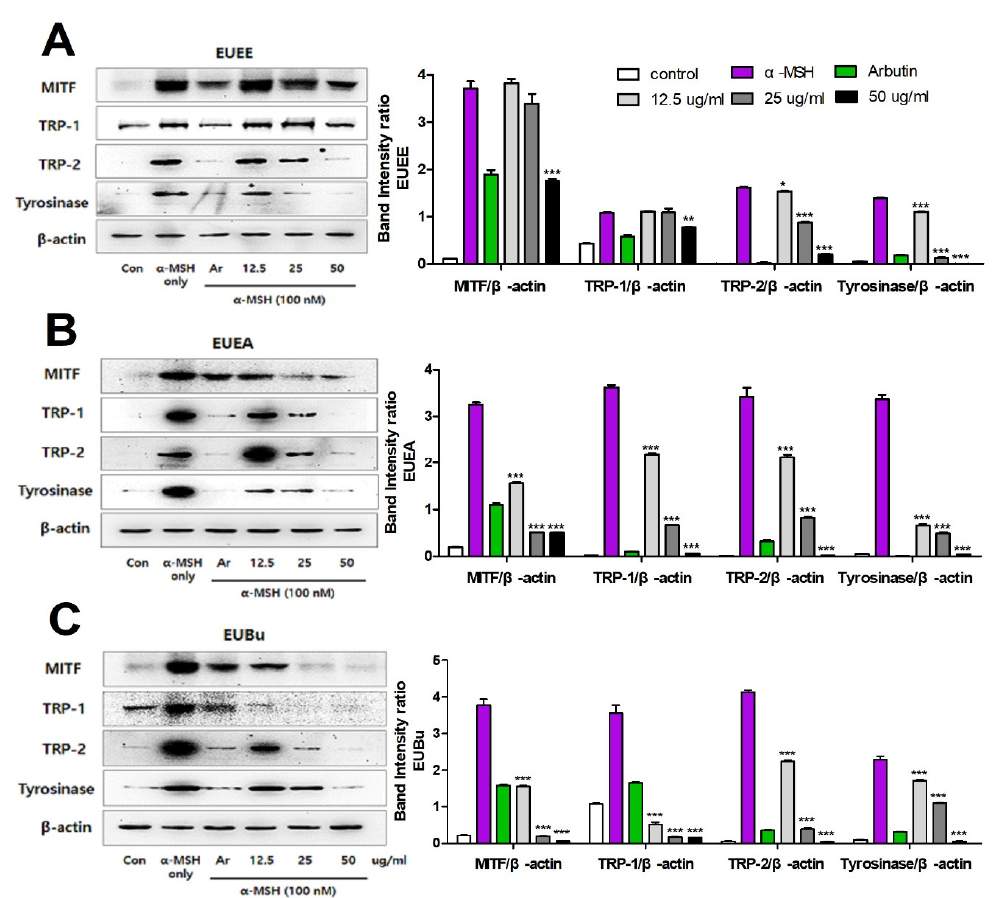
Figure 6. Inhibitory effect of EU on melanogenesis-related MITF, TRP-1, TRP-2, and tyrosinase proteins expression. Representative western blotting band image of MITF, TRP-1, TRP-2, and tyrosinase of EUEE ( A ), EUEA ( B ), and EUBu ( C ). Using the GelQuantNET program, the relative intensity of the western blotting band is shown as the following bar graph; MITF/ β -actin, TRP-1/ β -actin, TRP-2/ β -actin, and tyrosinase/ β -actin. β -actin was used as the internal control of western blotting. Data are expressed as the means ± S.E.M. (n = 3). Statistical significance was set at * p < 0.05, ** p < 0.01, and *** p < 0.001 when compared with the α -MSH-stimulated B16-F10 cells.